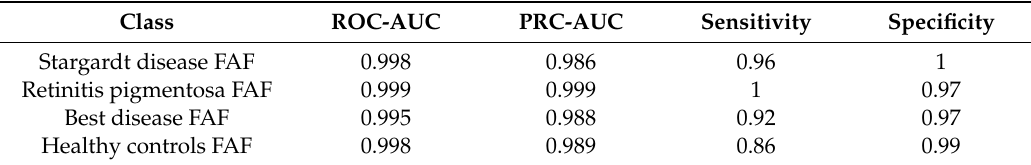
Table 1. Area under the curve (AUC) for receiver operating characteristics (ROC) and precision-recall (PRC) curves and sensitivity and specificity of the deep learning classifier for inherited retinal diseases (IRDs) fundus autofluorescence (FAF) images.